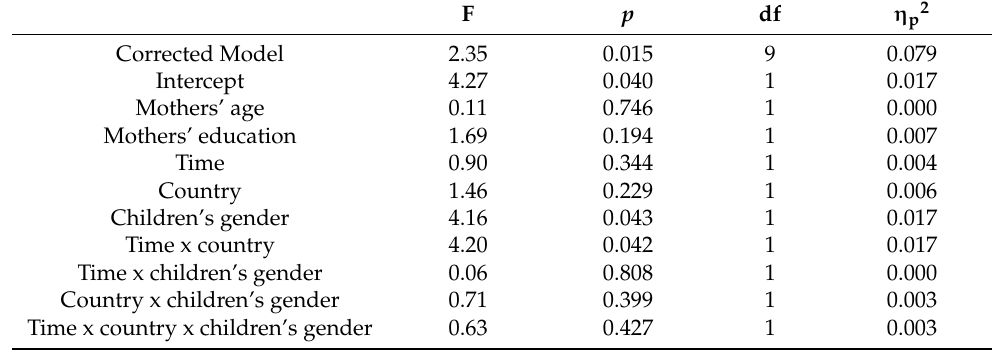
Table 4. Main and interaction effects (ANCOVA) of time (12 or 30 m), mothers’ country and children’s gender predicting mothers’ regulatory talk (controlled for mothers’ age and education).